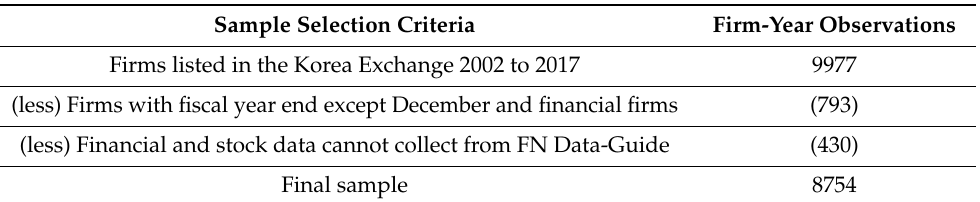
Table 1. Sample selection.